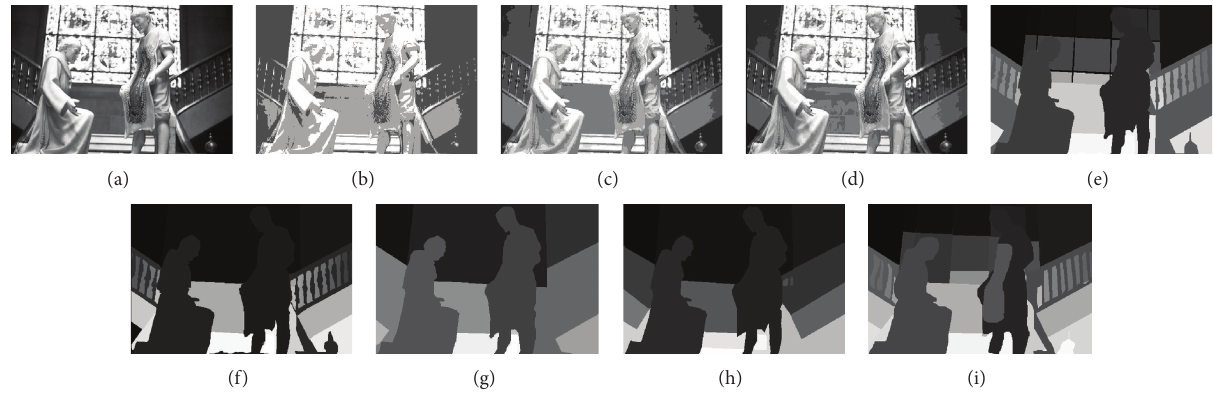
Figure 10: (a) Original image 24077, (b) M − 1 = 2 PRI = 0.68224 , (c) M − 1 = 5 PRI = 0.79134 , (d) M − 1 = 9 PRI = 0.84109 , (e)–(i) the ground-truth hand segmentations offered by Berkeley Segmentation Dataset.